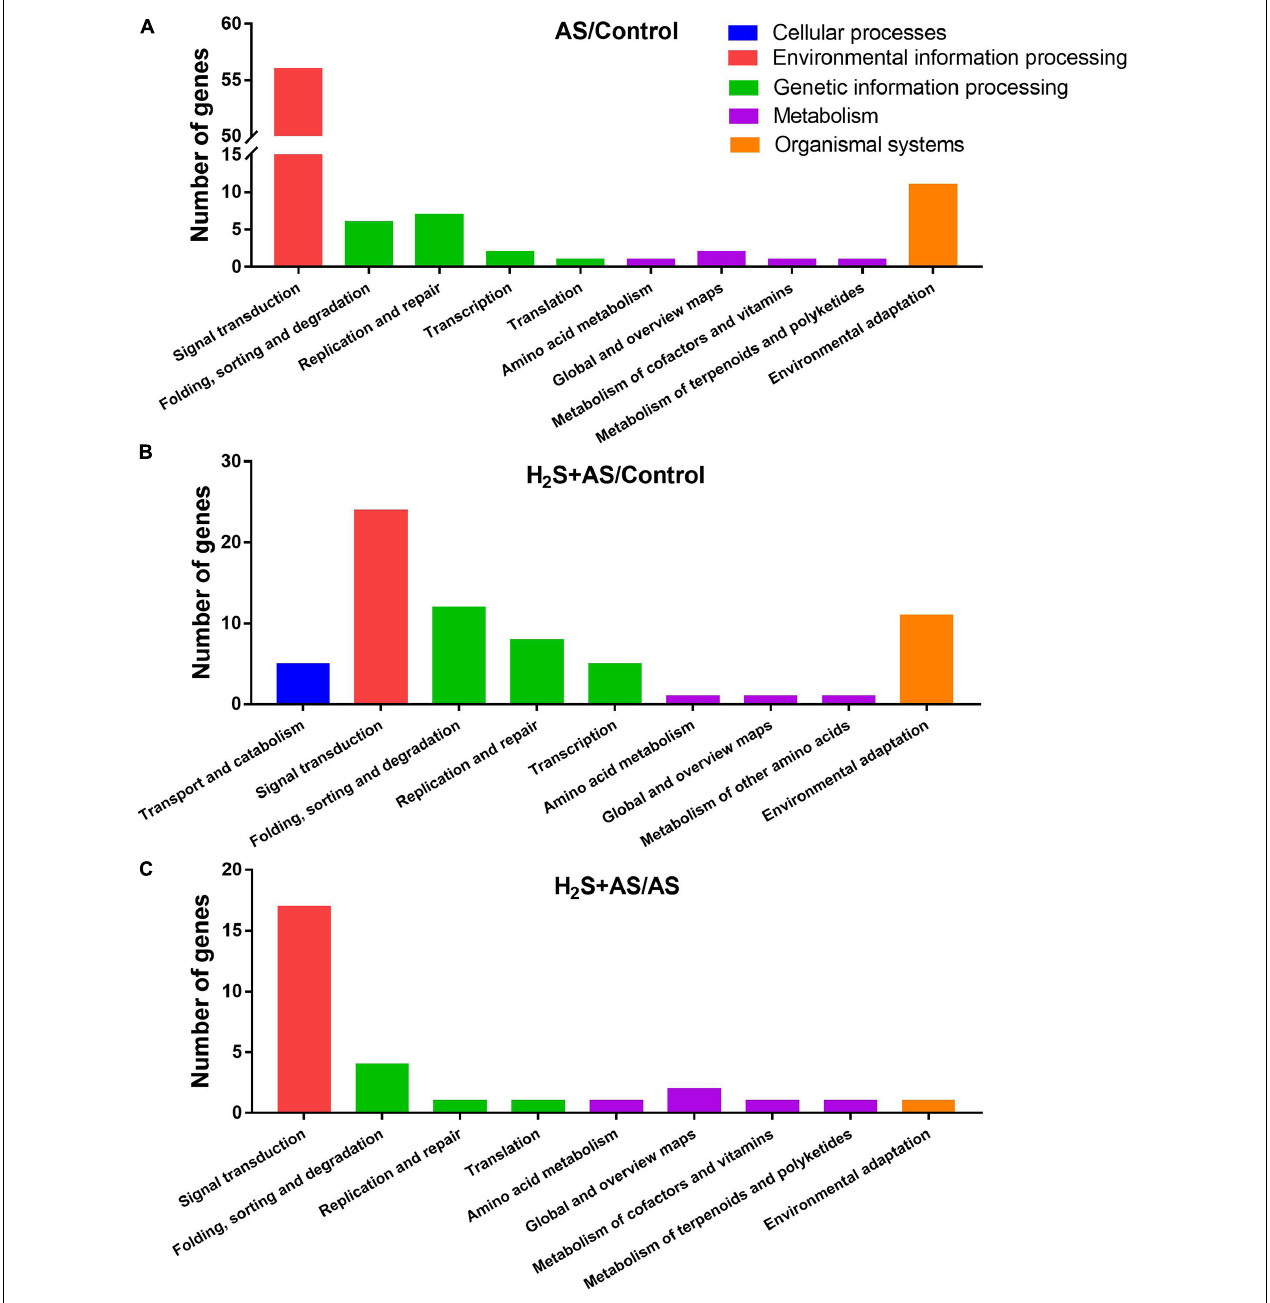
FIGURE 6 | KEGG classification of predicted target genes for the identified miRNAs. Blue, red, green, purple, and orange represent five KEGG ontologies: Cellular processes, Environmental information processing, Genetic information processing, Metabolism, and Organismal systems, respectively. (A) Number of genes under AS stresses as compared with control treatment; (B) number of genes under H 2 S + AS stresses as compared with control treatment; (C) number of genes under H 2 S + AS stresses as compared with AS